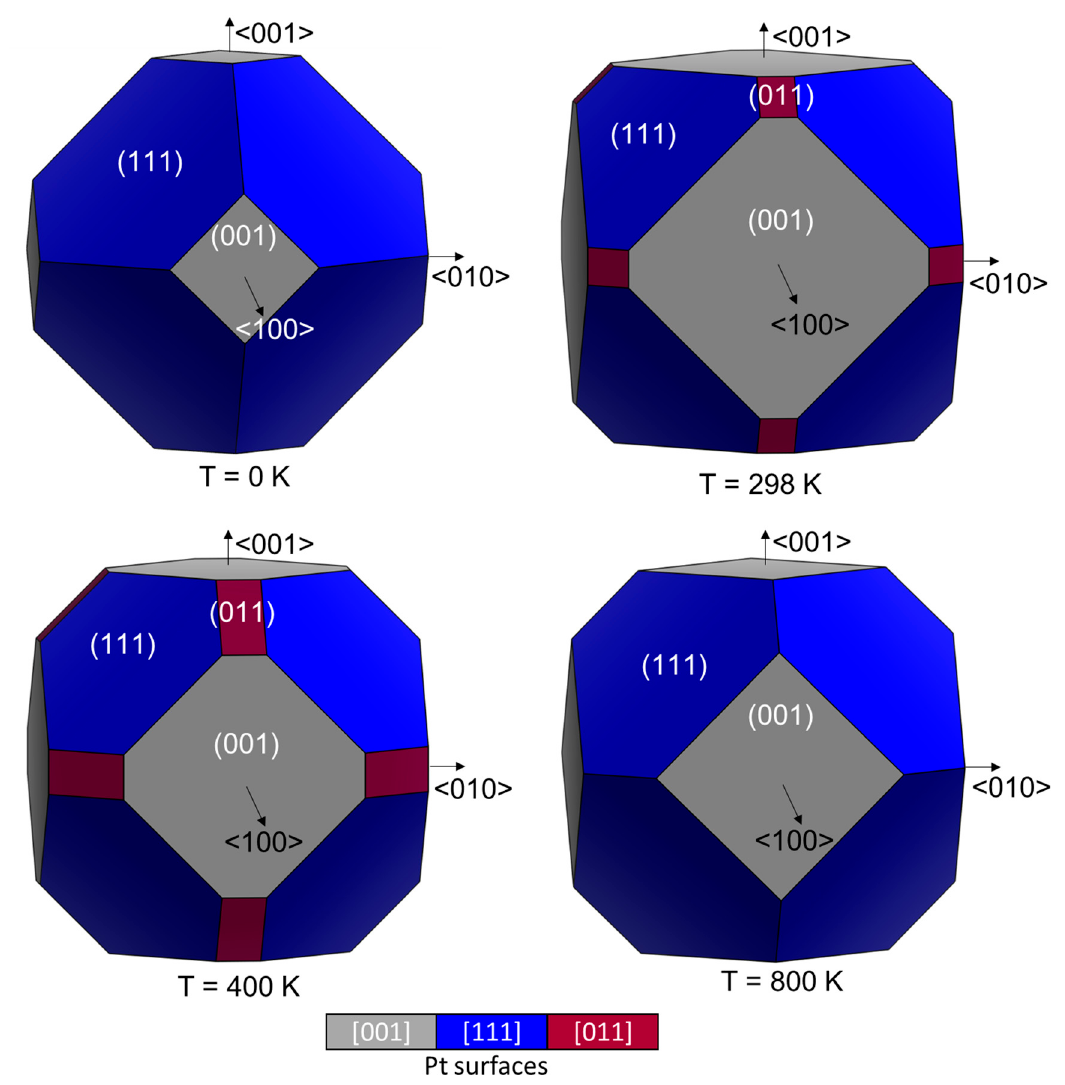
Figure 8. Wul ff morphology of Pt nanoparticles at 0, 298, 400, and 800 Figure 8. Wulff morphology of Pt nanoparticles at 0, 298, 400, and 800 K.